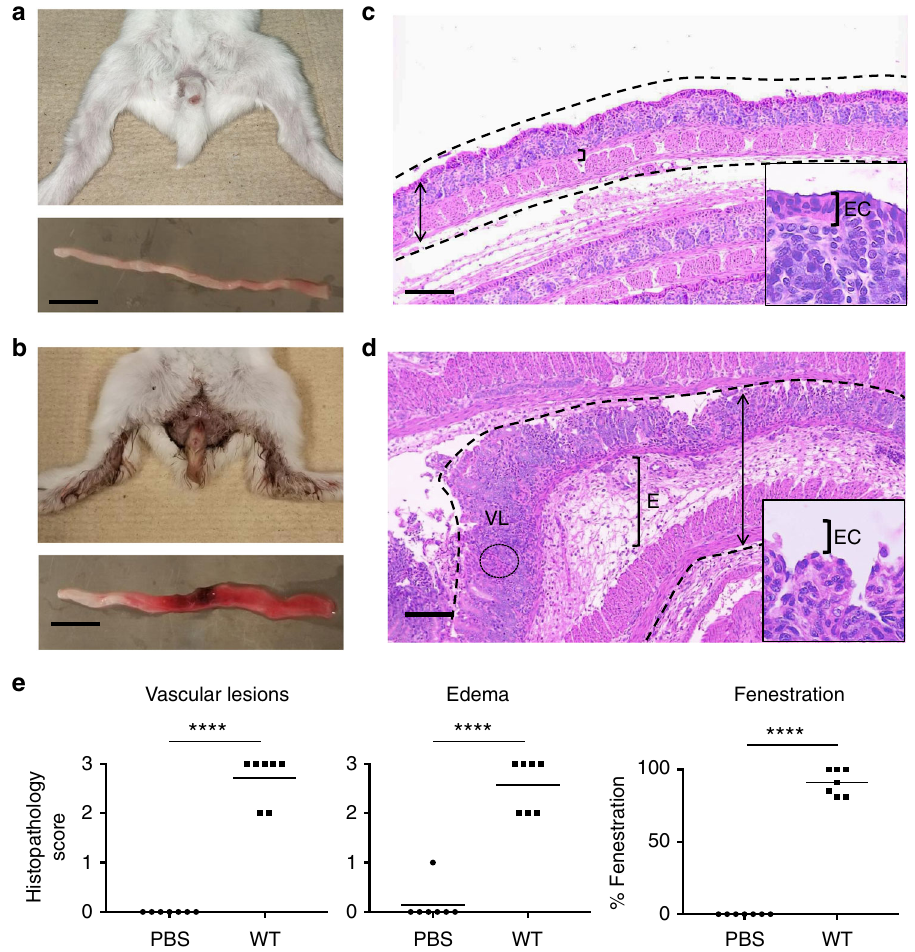
Fig. 1 Symptoms and histopathology in infant rabbits infected with Shigella fl exneri . a , b Representative images of animals (top) and colon (bottom) inoculated with phosphate-buffered saline (PBS) ( a ) or S. fl exneri ( b ). Scale bar, 2 cm. c , d Representative images of hematoxylin- and eosin-stained colonic sections from animals inoculated with PBS ( c ) or S. fl exneri ( d ). Dotted lines delineate the colon. Double arrows indicate the width of the colon section with massive swelling in d . Brackets indicate the width of connective tissues with edema (E). VL indicates vascular lesions with red blood cells. Insets: high magni fi cation of epithelial cells (EC) with fenestration in d . Scale bars, 100 μ m. e Histopathology scores of VLs, edema (E), and percentage of epithelial fenestration (EF). Statistical analysis, unpaired t test. Shigella fl exneri (wild type (WT)) vs. mock (PBS): VL, **** P < 0.0001; E, **** P < 0.0001; EF, **** P < 0.0001. Source data are provided as a Source Data fi